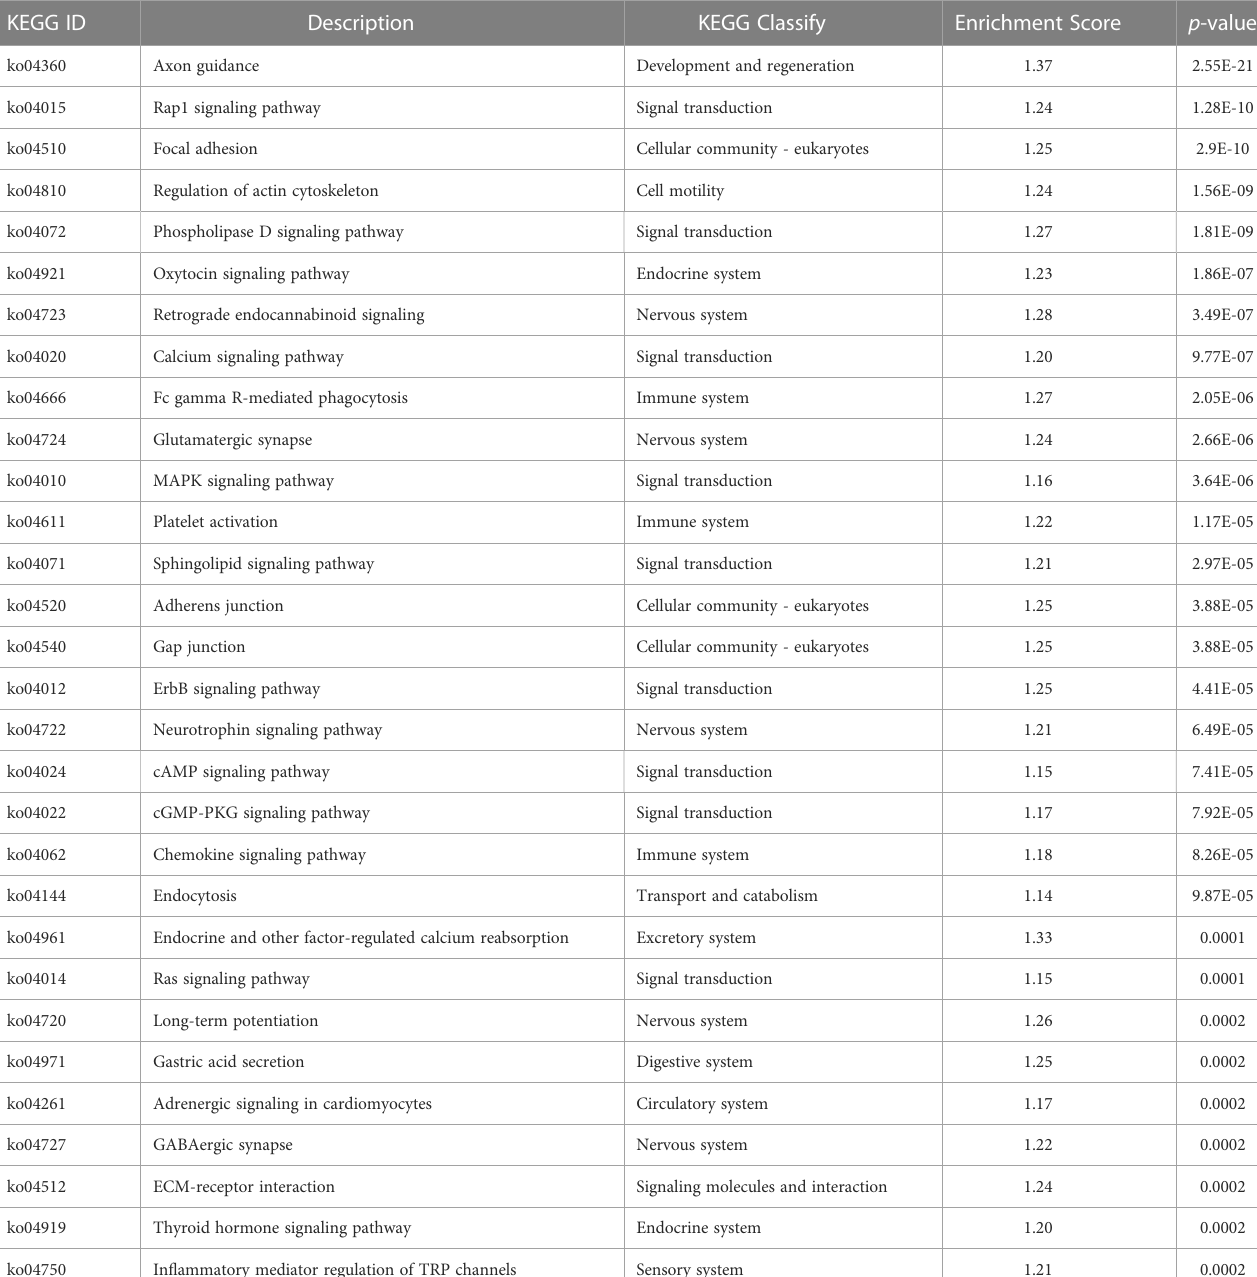
TABLE 5 KEGG analysis of DMRs target DMGs in gills of large yellow croaker under low-salinity stress. KEGG